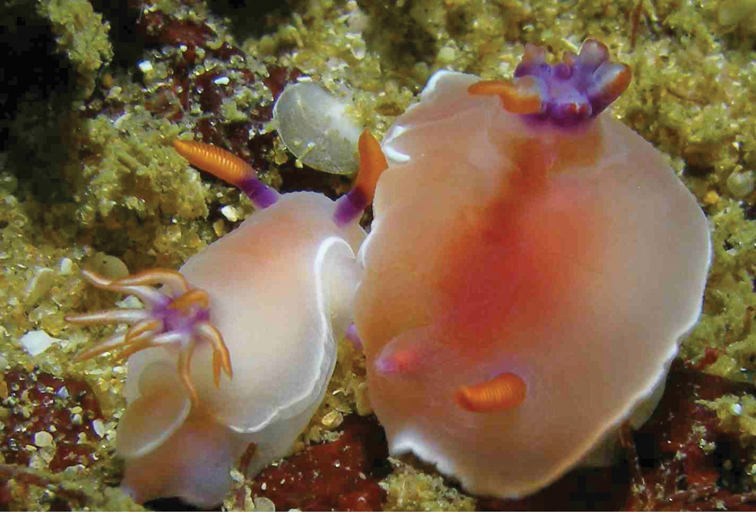
Risbecia bullockii, 11 and 16 mm pres., Sri Lanka, S Kahlbrock.